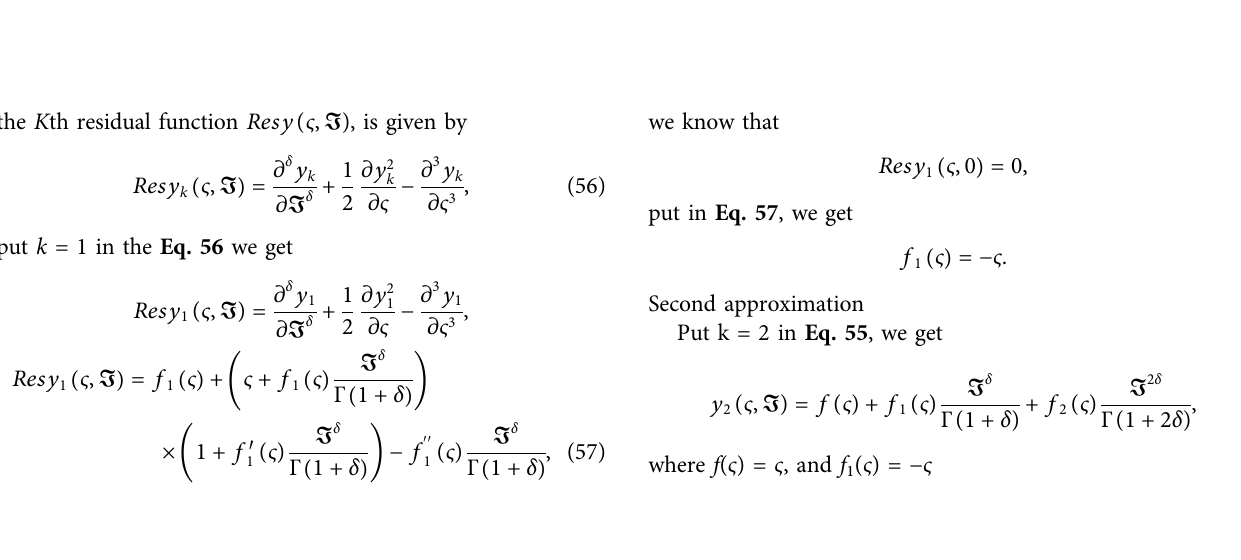
FIGURE 4 | 3D plots of (A) RPSM (B) Exact (C) q-HATM-solutions at δ = 1 of Example